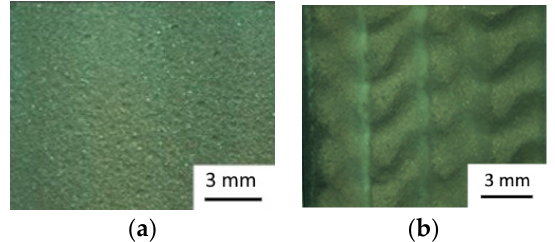
Figure 4. Morphologies of the deposited coating surfaces—flat ( a ) and wavy ( b ).